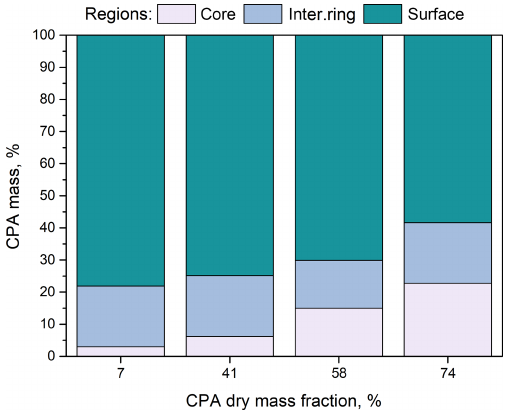
Figure 5. Percentage of CPA molecules in the three regions (core, intermediate ring, outer surface) of the simulated nanoparticles as a function of dry organic mass fraction at low-RH conditions.